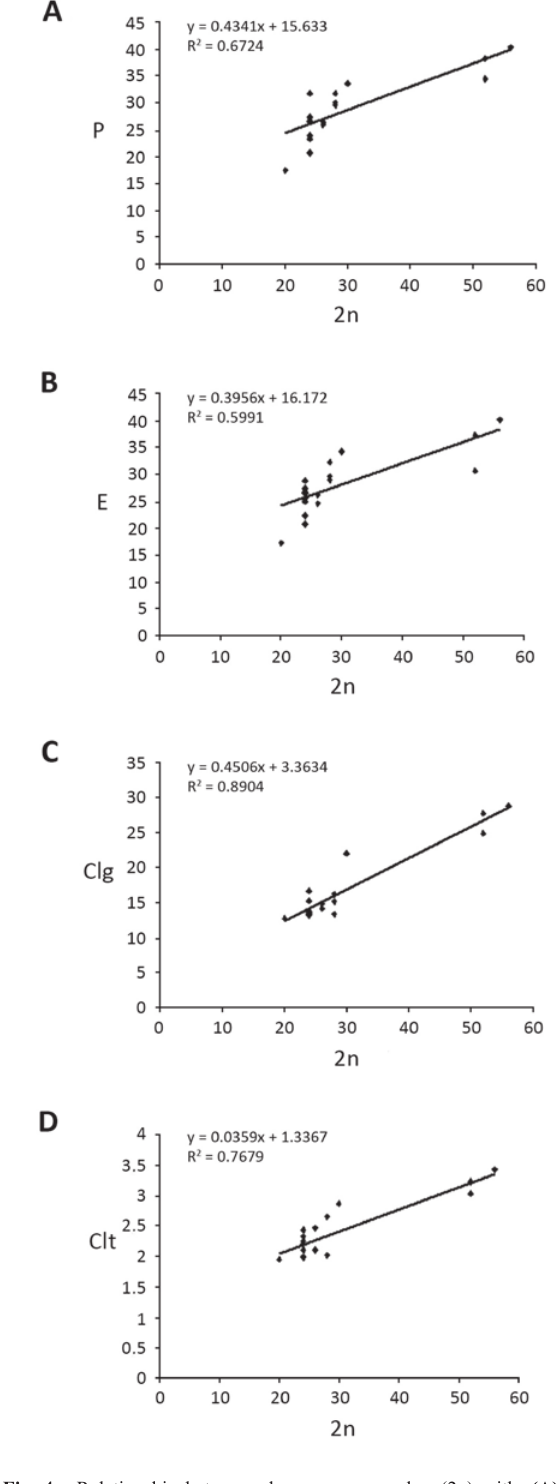
Fig. 4 - Relationship between chromosome number (2n) with: (A) polar axis diameter, (B) equatorial diameter, (C) colpus length and (D) colpus